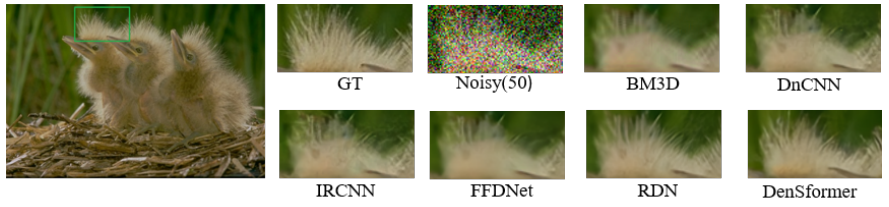
Figure 3. Gray-scale image denoising results with noise level σ = 50.